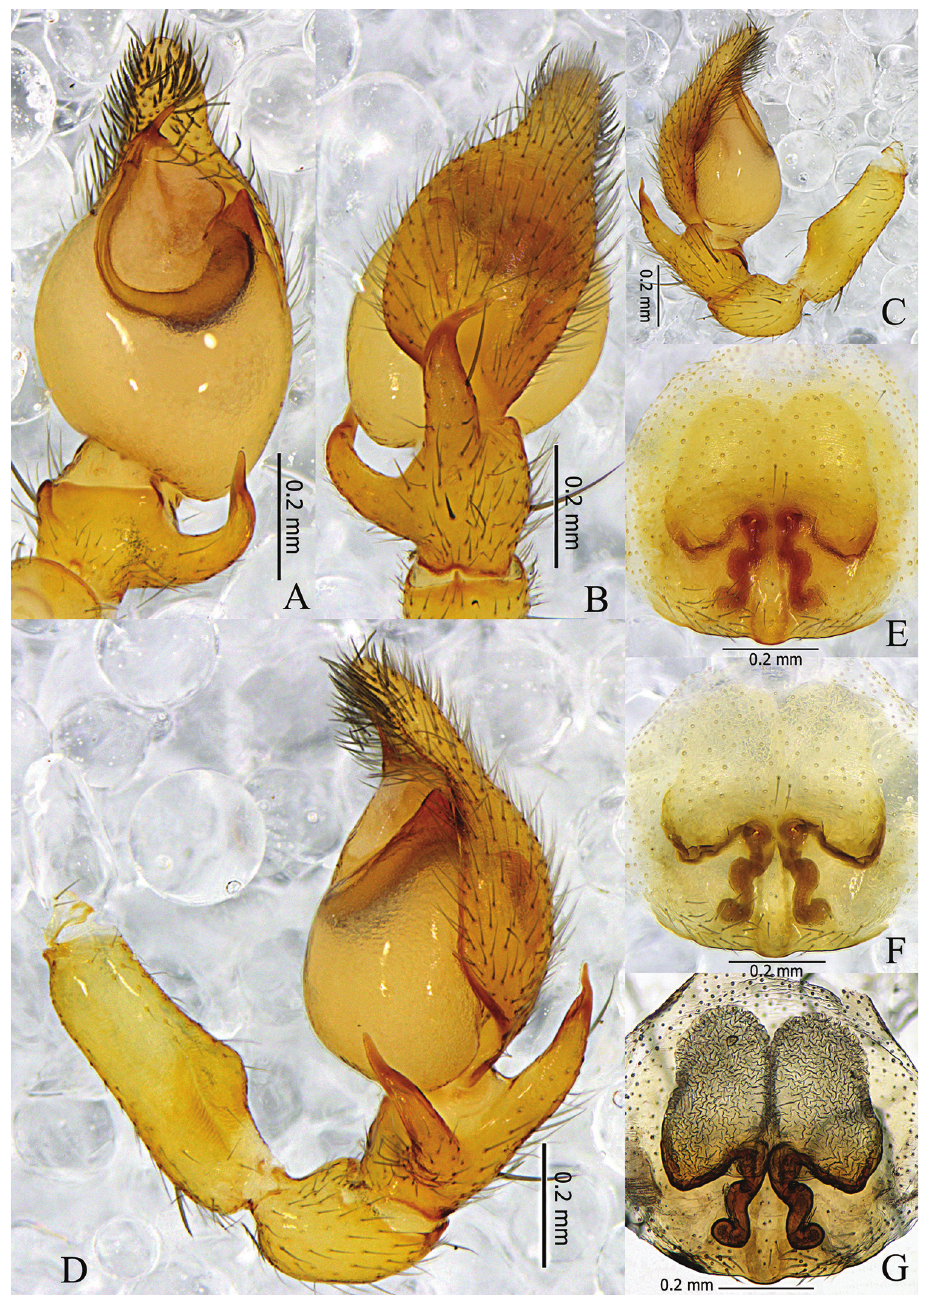
Figure 2. Otacilia hippocampa sp. n. A left male palp, ventral view B same, dorsal view C same, pro- lateral view D same, retrolateral view E epigyne, ventral view F same, cleared by potassium hydroxide, ventral view G vulva, dorsal